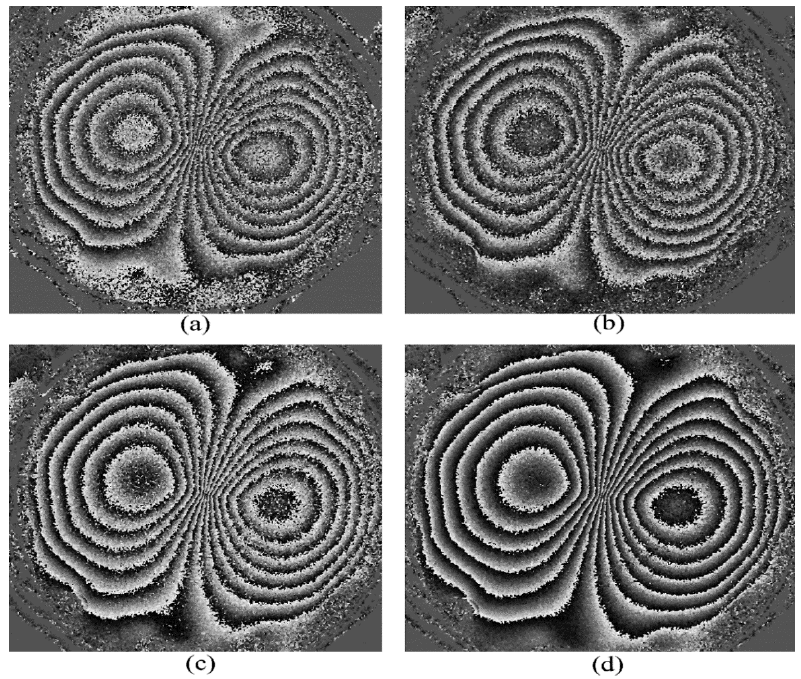
Figure 7. Phase map generated for a 55 μ m central deformation by different phase-stepping algo- rithms from the Nikon D5300 camera, ( a ) 4 + 1, ( b ) 3 + 1, ( c ) 3 + 2, and ( d ) 3 + 3.